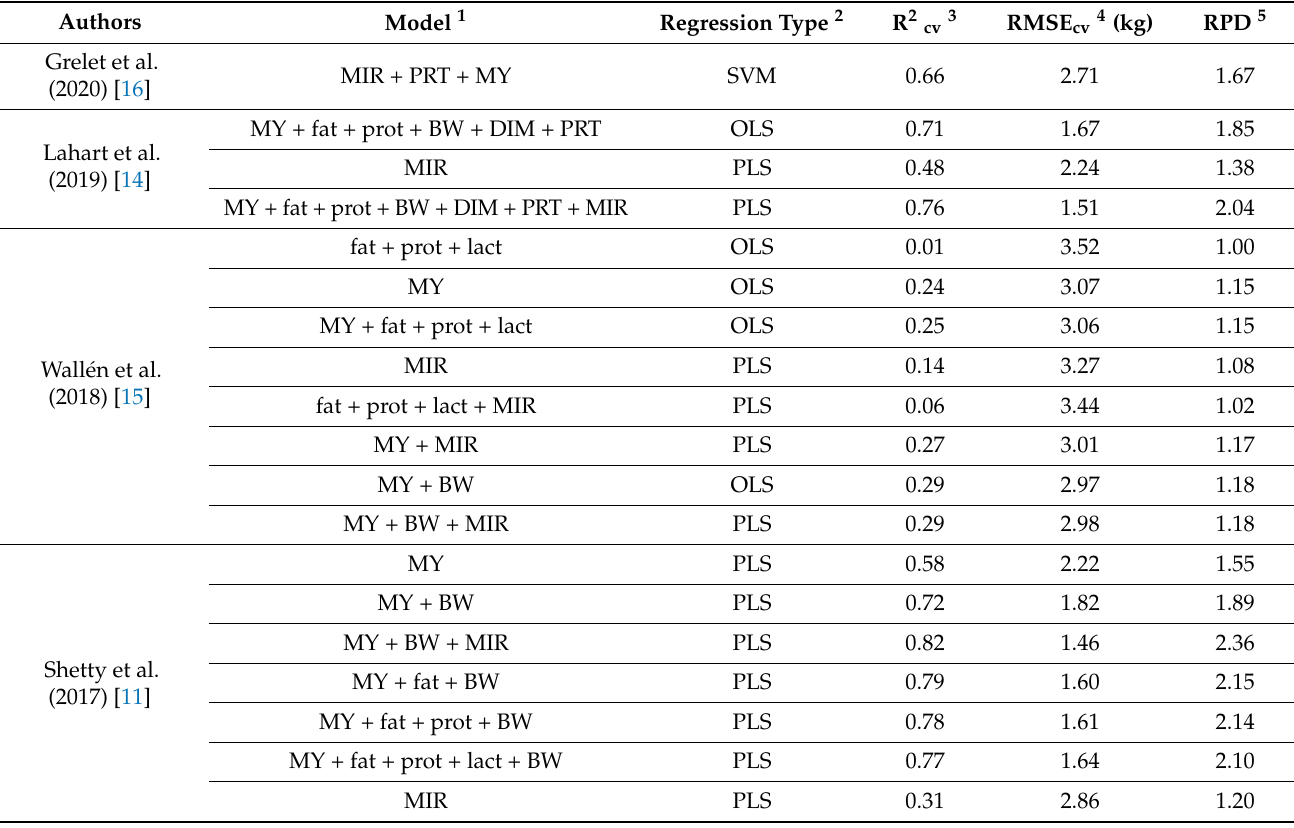
Table 1. Structure and prediction performance of recent literature models predicting the dry matter intake of dairy cows.